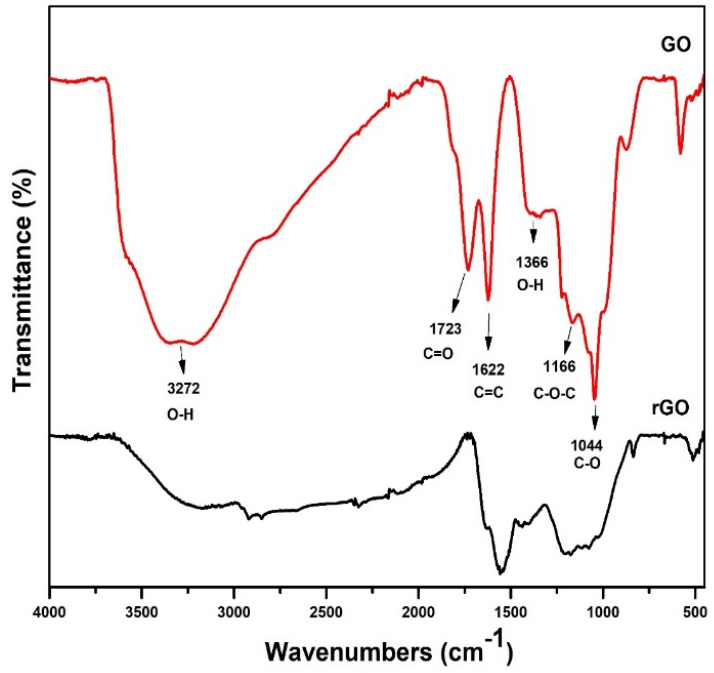
Figure 6. FT-IR spectrum of GO and rGO. Figure 6. FTIR spectrum of GO and rGO.